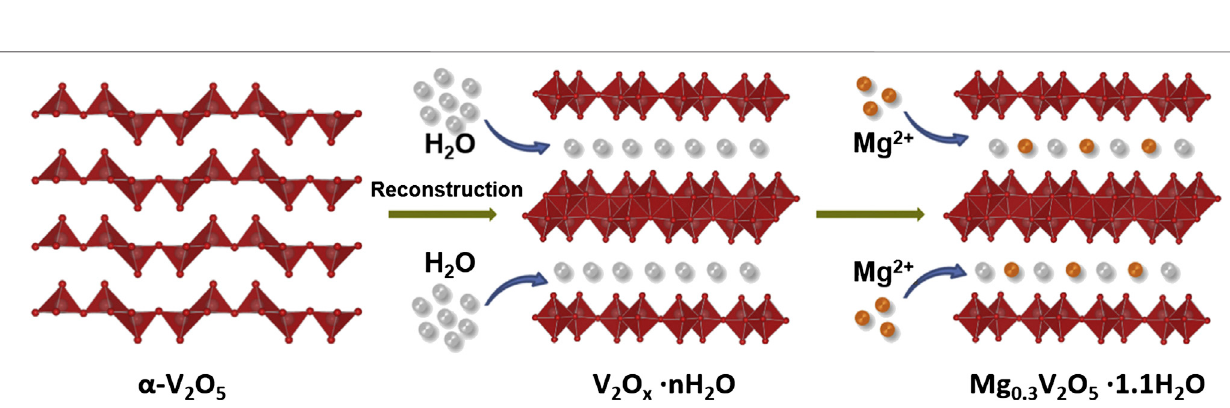
Frontiers in Energy Research |